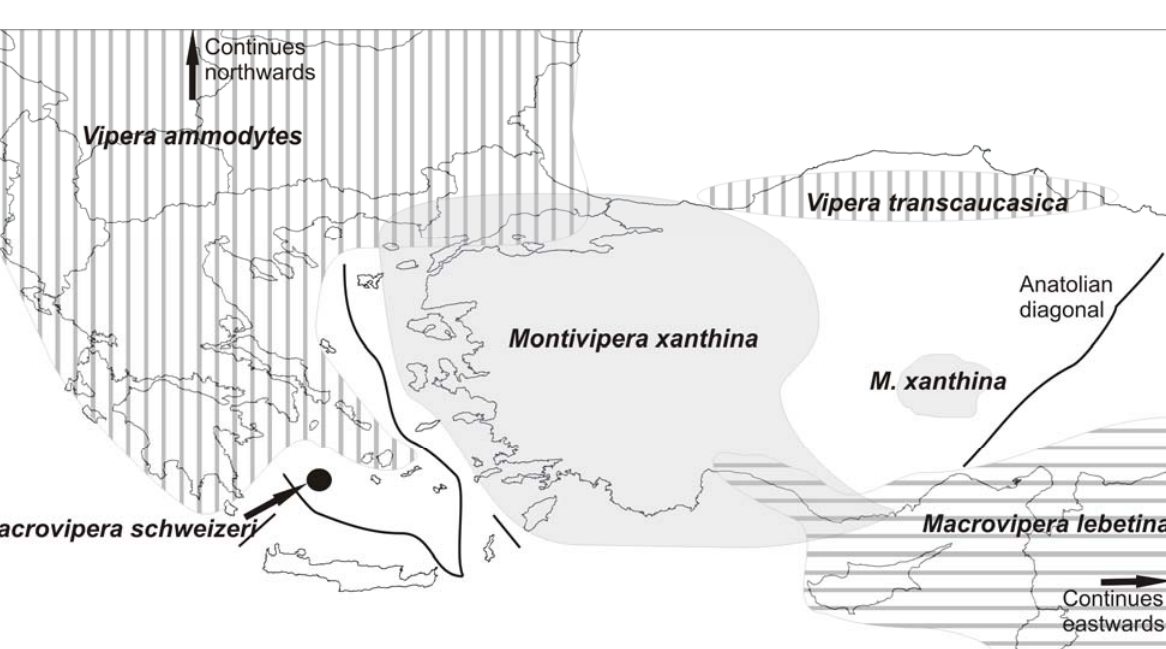
Figure 10. Approximate distributions of certain vipers in the Aegean area. Not mentioned V. ammodytes . Another isolated population of the species (not shown) occurs east of the Anatolian diagonal. A vicariant event and/or competition with M. xanthina may have been responsible for the gap in V. ammodytes distribution. Note that despite their long history in the area, vipers respect the MAT as well as the Anatolian Diagonal and they appear to have never reached the southern